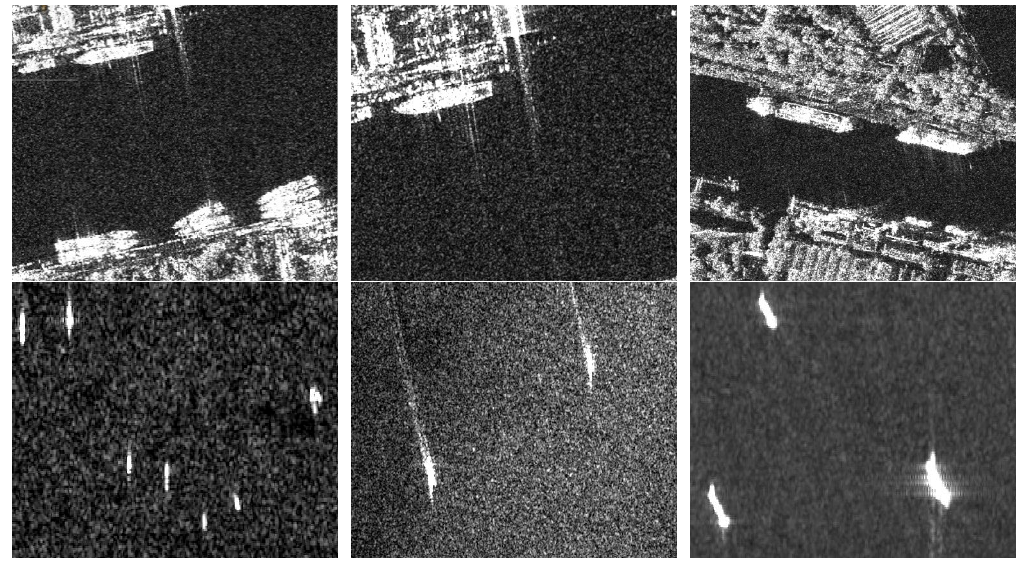
Table 1. Corresponding relationships between NoS and NoI in SSDD.